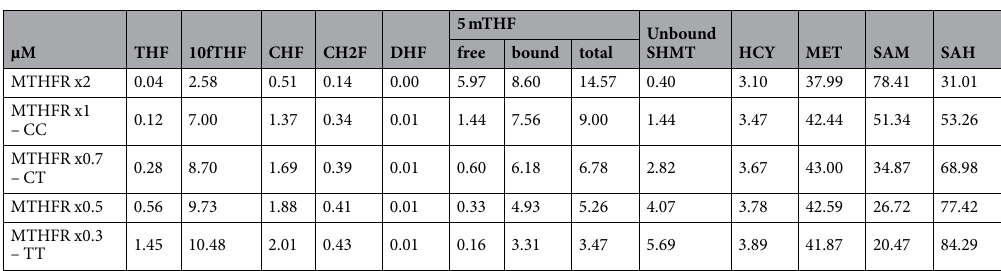
Table 2. Concentrations of model variables (in µ M) for different levels of MTHFR activity (ranging from 2x to 0.3x of wild type). CC, CT and TT refer to the C667T polymorphism.